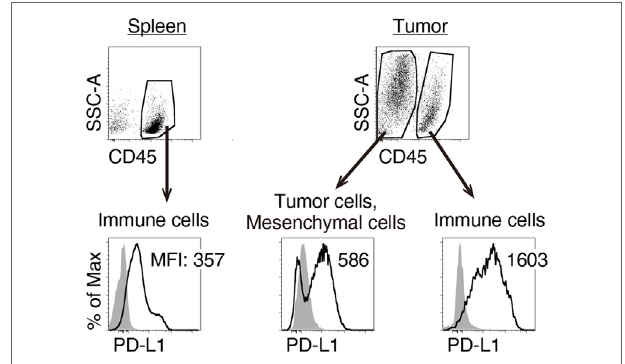
FigUre 4 | Splenic and intratumor immune cells express programmed death ligand-1 (PD-L1). MO5-bearing mice were euthanized 16 days after tumor implantation. PD-L1 expression levels on splenic CD45 + cells, intratumor CD45 − and CD45 + cells were analyzed by flow cytometry. Shaded and open histograms indicate isotype control and PD-L1 staining, respectively. The results are representative of more than three independent